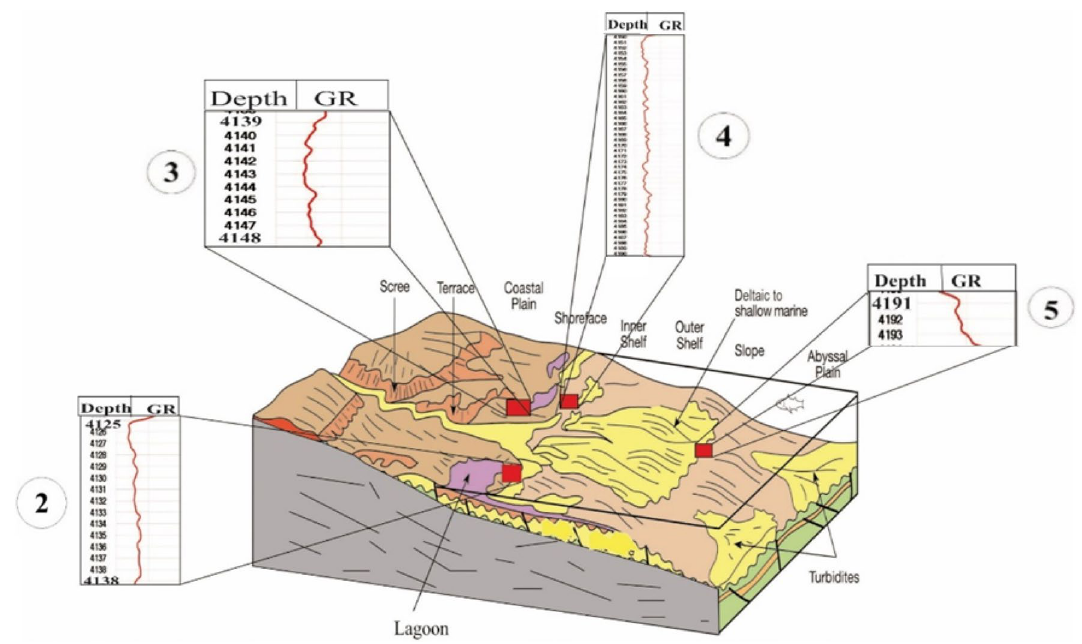
Fig. 23 Depositional model for Lockhart limestone of Meyal-10P. The log trends are from GR